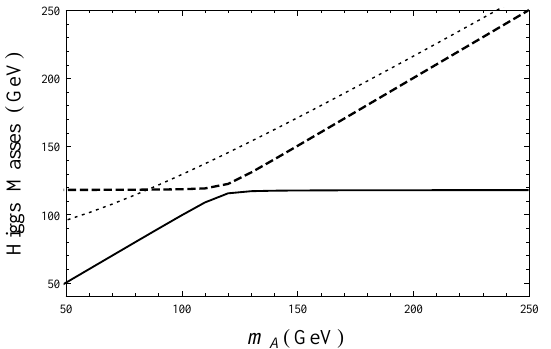
Figure 2. One-loop predictions of the Higgs boson masses m h (solid), m H (dashed), and m ± (dotted) as a function of the CP-odd Higgs boson mass m A . We have considered tan β = 30 in a scenario where M SUSY = 1 TeV and µ = 200 GeV.